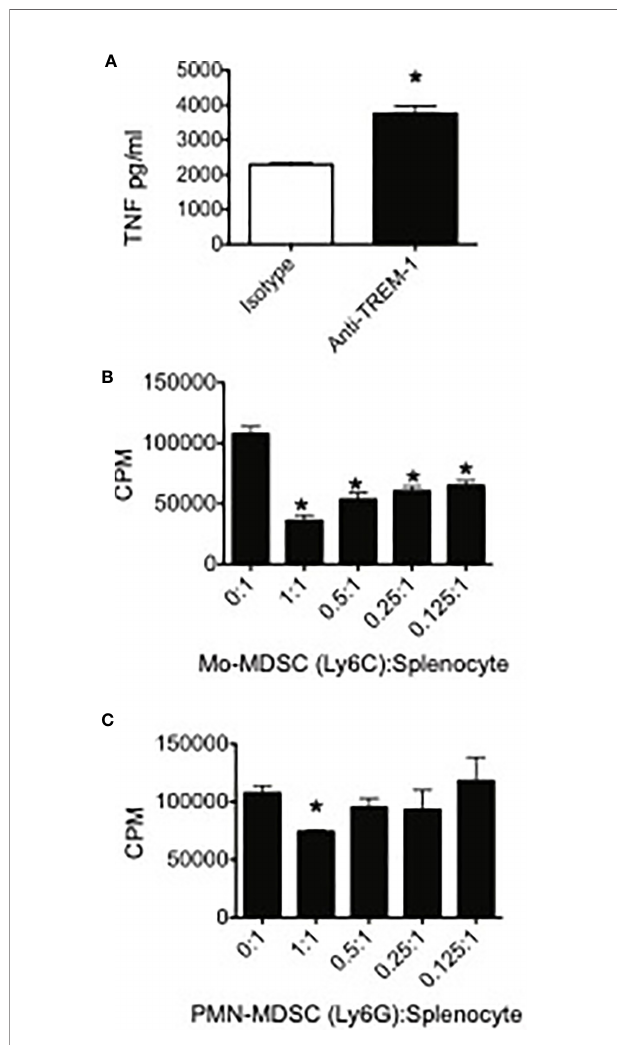
FIGURE 2 | TREM-1 engagement enhances pro-in fl ammatory cytokine release by myeloid-derived suppressor cells (MDSC) and Trem-1 + MDSC from tumor-bearing mice suppress T cell proliferation. (A) Peripheral myeloid- derived suppressor cells were sorted from spleens of 4T1 tumor-bearing mice, plated onto wells coated with either anti-TREM-1 or rat IgG2A isotype control Ab, and stimulated with lipopolysaccharide. The supernatants were harvested 20 h later, and the TNF levels in the supernatants were measured by ELISA. * p < 0.05. (B) Ly6C + CD11b + (Mo) and (C) Ly6G + CD11b + (PMN) MDSC were sorted from spleens of 4T1 tumor-bearing mice. The cells were cultured at the indicated ratios with splenocytes from naïve BALB/c mice. Con A was added to each well at a fi nal concentration of 2 m g/ml. Tritiated thymidine incorporation was measured during the last 18 h of the 85-h incubation period. * p -value <0.05 relative to no suppressors. Data represents mean ± SEM from triplicates of a representative